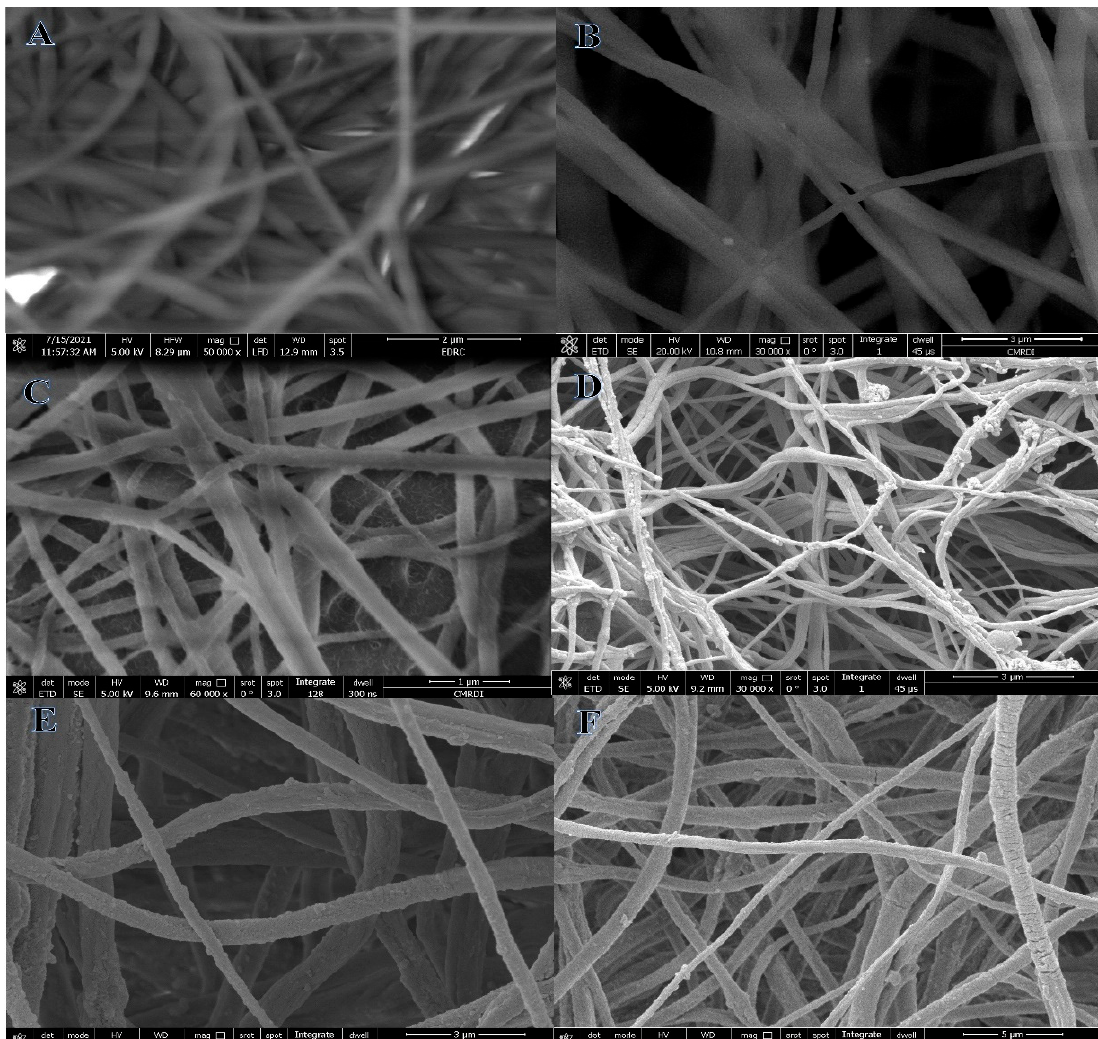
Figure 1. Low and high magnifications of SEM images PVDF-HFP ( A ), Ni 0.9 Cu 0.1 /PVDF-HFP ( B ), Ni 0.7 Cu 0.3/ PVDF-HFP ( C ), Ni 0.5 Cu 0.5 /PVDF-HFP ( D ), Ni 0.3 Cu 0.7 /PVDF-HFP ( E ), Ni 0.1 Cu 0.9 /PVDF-HFP NF membranes ( F ).